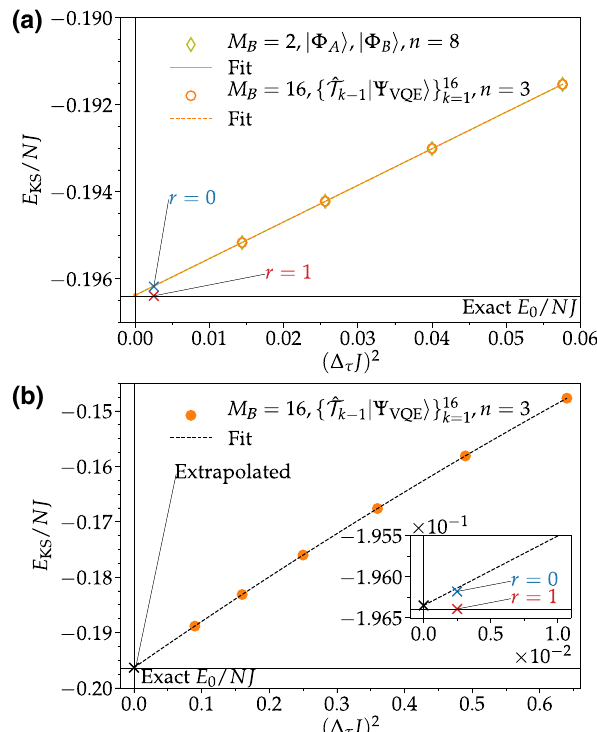
FIG. 7. (a) Ground-state energy E KS evaluated for the spin- 1/2 Heisenberg model on an N = 16 qubit ring by setting the Krylov-subspace parameters ( M B , n ) = ( 2, 8 ) (diamonds) and = 0.12, 0.16, 0.2, and 0.24 without ( 16, 3 ) (circles) at (cid:3) τ J the Richardson extrapolation. The lines are fits to the two sets of data obtained separately by assuming the form E KS / NJ = a ((cid:3) τ J ) 2 + b with a and b being fitting parameters. (b) Same as (a) but for ( M B , n ) = ( 16, 3 ) at (cid:3) τ J = 0.3, 0.4, 0.5, 0.6, 0.7, and 0.8 without the Richardson extrapolation. The dashed line is a fit to the data obtained by assuming the form E KS / NJ = a ((cid:3) τ J ) 4 + b ((cid:3) τ J ) 2 + c with a , b , and c being fitting parame- ters, and the extrapolated value at (cid:3) τ = 0 is indicated by black cross. The inset is an enlarged plot. For comparison, the results for ( M B , n ) = ( 16, 3 ) at (cid:3) τ J = 0.05 with r = 0 and 1 are also indicated by blue and red crosses, respectively, in (a) and the inset of (b). Note that the result with r = 1 corresponds to that shown in Fig. 5. The horizontal line indicates the exact ground-state energy E 0